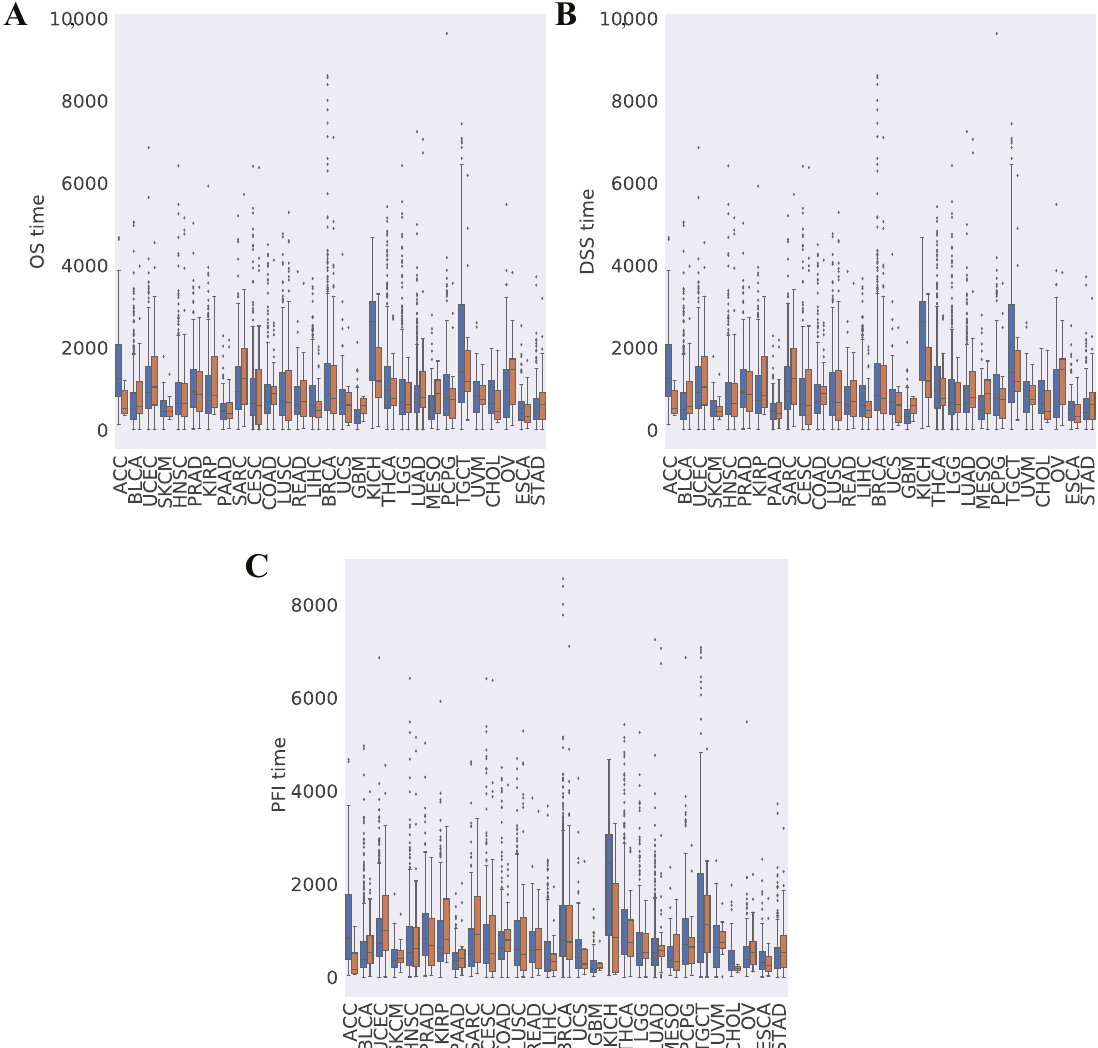
Figure A2. Boxplots of OS ( A ), DSS ( B ), and PFI ( C ) for TMB/TGF- β score positive cases (orange) and negative cases (blue) in the context of the different cancer types. Time is expressed in days. Abbreviations of cancer cohort: adrenocortical carcinoma (ACC), bladder urothelial